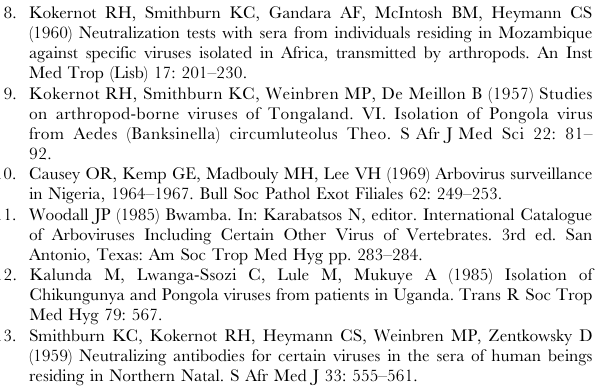
Figure S1 Phylogenetic relationships among the BWAV/ PGAV and NDV/MDCV/KKV group viruses as inferred using the Neighbor-Joining method. Neighbor-Joining trees were constructed using the Tamura-3 parameter model on the nucleotide sequences of the S segment, M segment and L segment, as indicated. Bootstrap values based on 1,000 replicates are indicated. Viruses lineages added based on sequences determined as a part of this study are indicated in color: Bwamba virus (orange), Pongola virus (red), Nyando virus (blue), Mojuı´ dos Campos virus (purple), Kaeng Khoi virus (pink). Figure S2 Comparison of 3 9 and 5 9 untranslated region (UTR) sequences in BWAV/PGAV and NDV/MDCV/ KKV group viruses. The 3 9 and 5 9 UTR sequences are shown for the indicated viruses. For comparison, prototype members of the Bunyamwera virus group (Bunyamwera virus) and California Encephalitis virus group (Jamestown Canyon) are also shown. Previously identified highly conserved terminal sequences are highlighted in blue, while start/stop codons are indicated in green. Sequences that are predicted to form base-pairing interactions between the two UTRs (3 9 - 3 nt/8 nt/4 nt…4 nt/8 nt/3 nt- 5 9 )